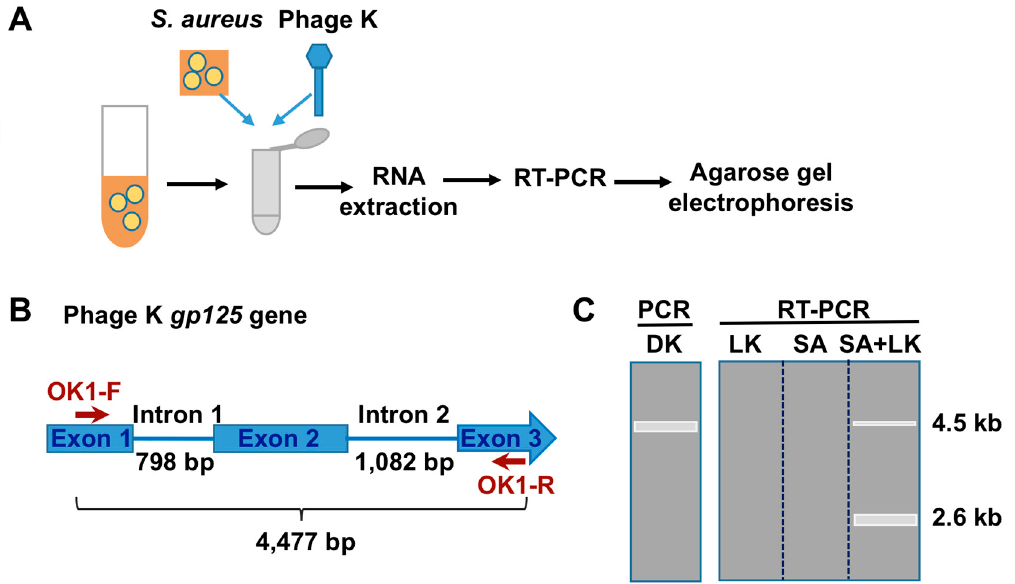
Figure 1. Schematic representation of the method and the predicted results using oligos in the 5’ and 3’ ends of phage K gp125 ORF. ( A ) Schematic representation of the method (see text for details). ( B ) Region and size of phage K gp125 amplified by the primers OK1-F and -R. The sizes of introns 1 and 2 are also indicated. ( C ) Expected gel electrophoresis results of PCR from phage K genomic DNA (DK), and from reverse-transcribed phage K lysates (LK), Staphylococcus aureus cells (SA), and SA cells infected with phage K (SA + LK). The predicted bands (light grey rectangles) and their sizes are indicated.